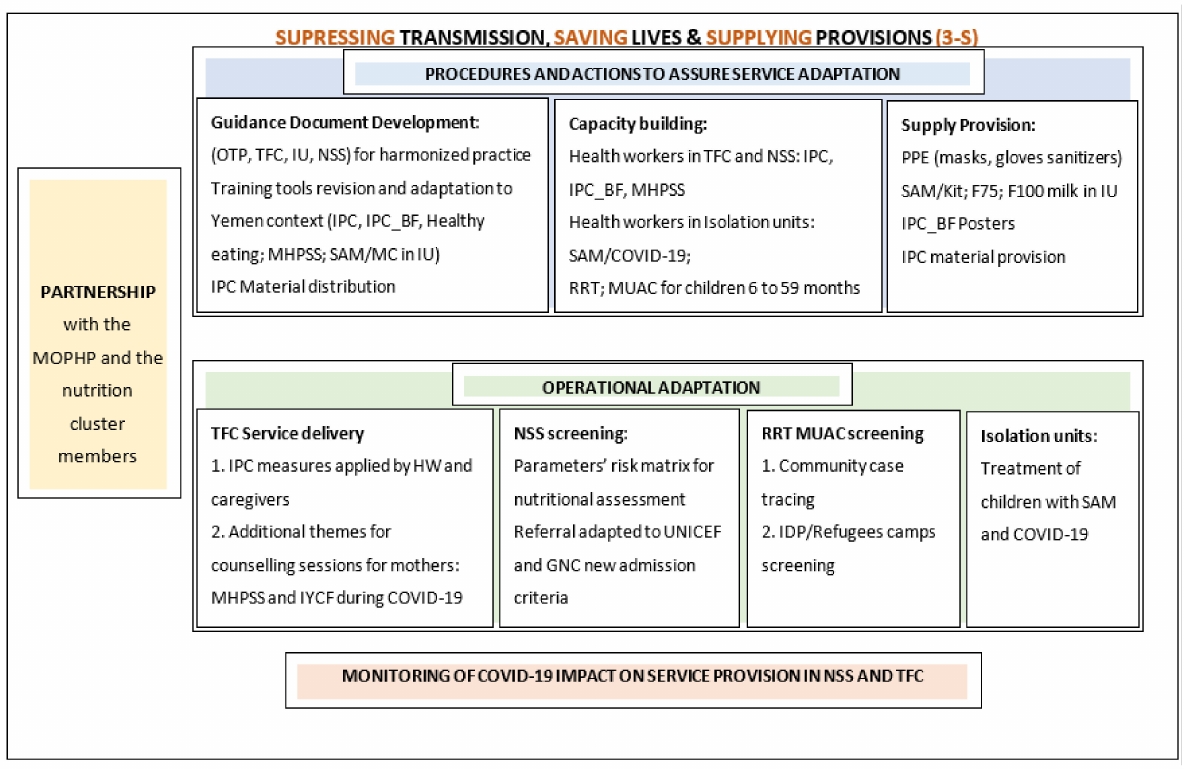
Figure 1. Strategic framework for the adaptation of the nutrition program in Yemen, amidst the COVID-19 pandemic: the 3-S plan. Abbreviations: COVID-19: coronavirus disease 2019; GNC: Global Nutrition Cluster; HW: health workers; IDP: internally displaced person; IPC: infection protection and control; IPC_BF: infection protection and control for breastfeeding; IU: isolation units; IYCF: infant and young child feeding; MC: medical complications; MHPSS: mental health and psychosocial support; MOPHP: Ministry of Public Health and Population; MUAC: mid-upper arm circumference; NSS: Nutrition Surveillance System; OTP: outpatient therapeutic program; PPE: personal protective equipment; RRT: rapid response team; SAM: severe acute malnutrition; TFCs: therapeutic feeding centers; UNICEF: United Nations Children’s Emergency